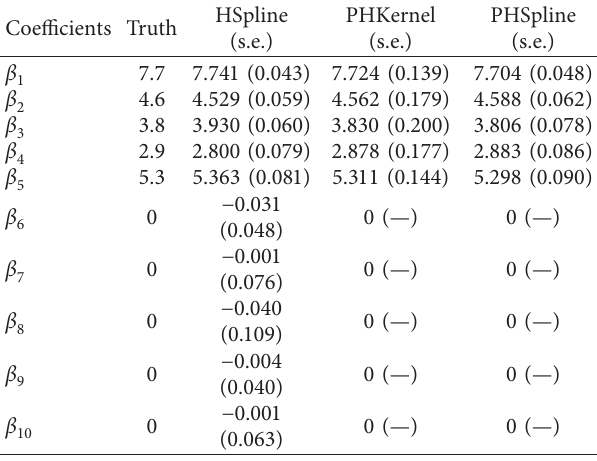
Table 3: Simulation result of Example 1.